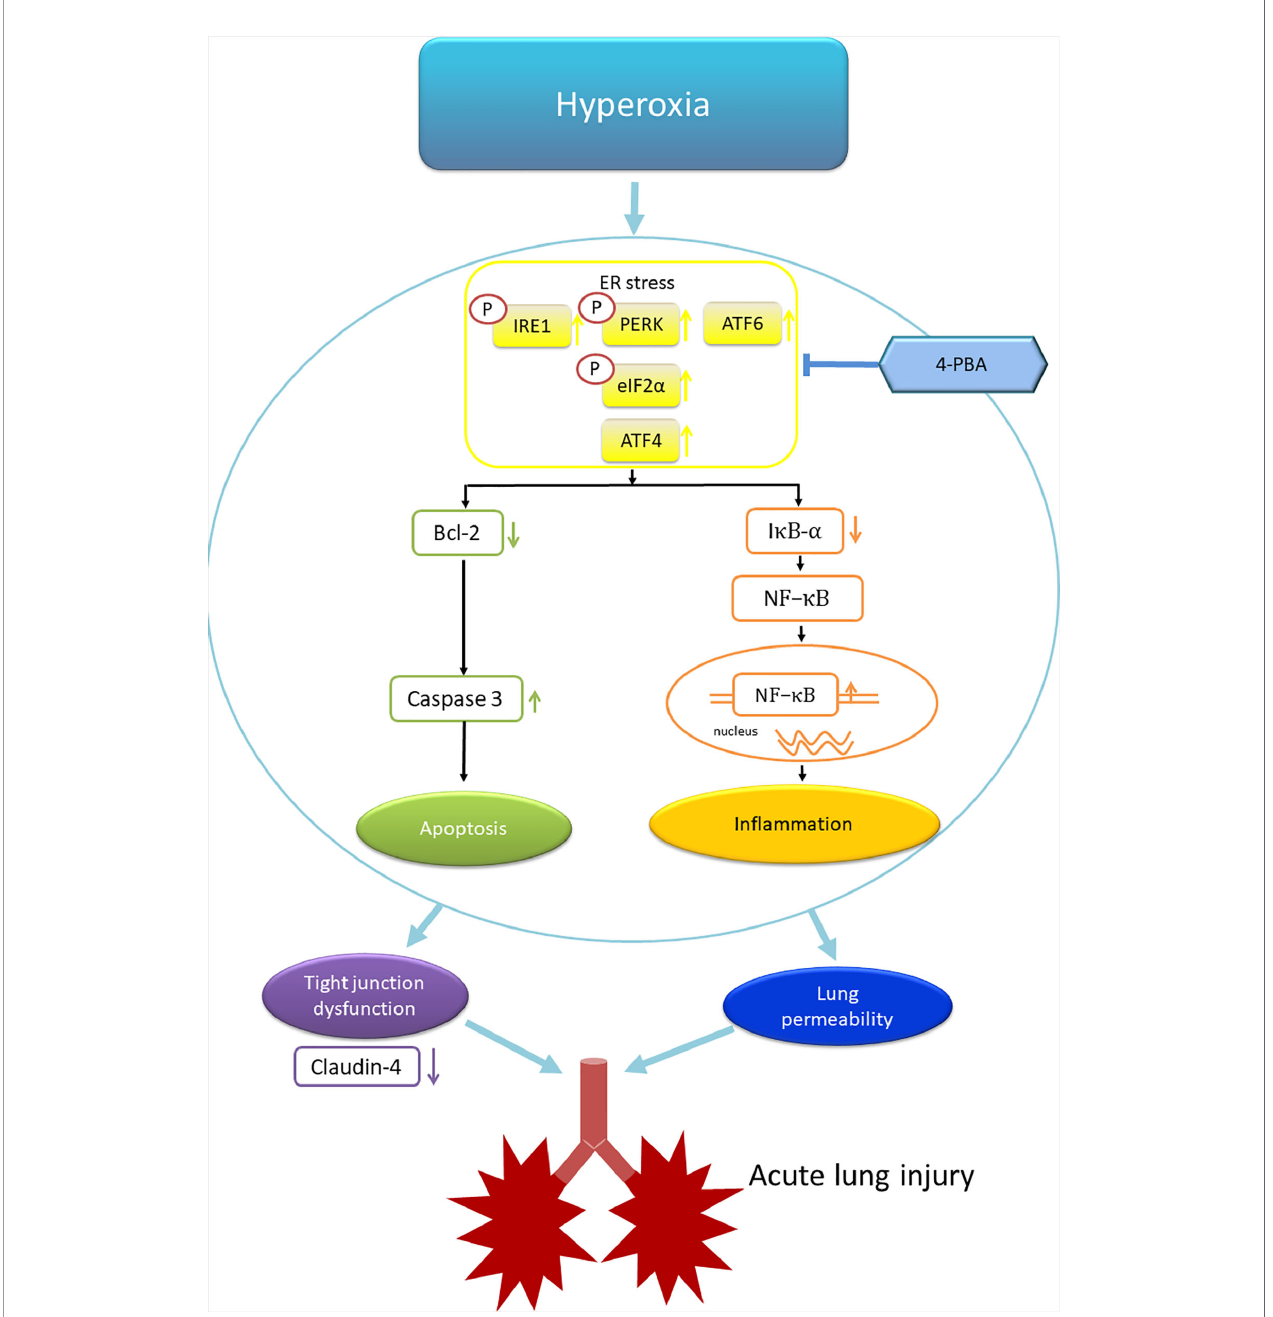
FIGURE 11 | Schematic shows that hyperoxia triggers endoplasmic reticulum (ER) stress responses that lead to in fl ammation and apoptosis. The in fl ammation and apoptosis impair tight junction function and lung vascular permeability that induce acute lung injury. 4-PBA administration improves these phenomena. ATF4, activating transcription factor 4; ATF6, activating transcription factor 6; IRE1, inositol-requiring enzyme 1; PERK, protein kinase-like ER kinase. p-elF-2 a , eukaryotic translation initiation factor 2 a